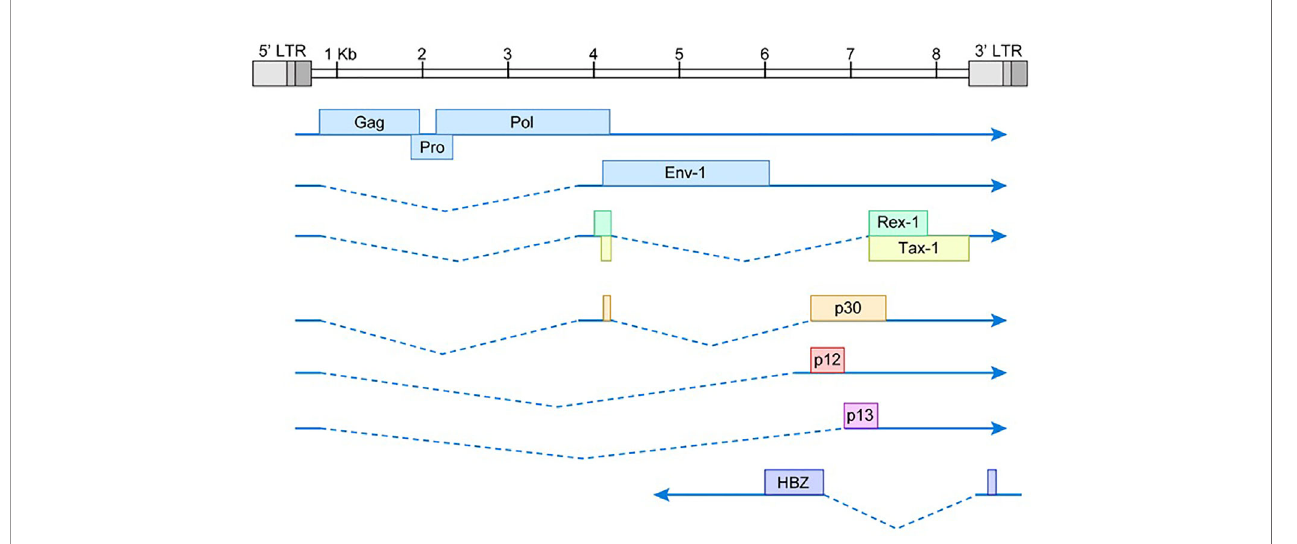
FIGURE 1 | Schematic of HTLV-1 proviral genome. The viral gag, pro, pol , and env structural/enzymatic genes are fl anked by 5 ’ and 3 ’ LTRs. The pX region at the 3 ’ end of the viral genome contains several regulatory and accessory genes. The dotted lines represent spliced regions of each gene product. Drawing is intended to be illustrative and not to exact